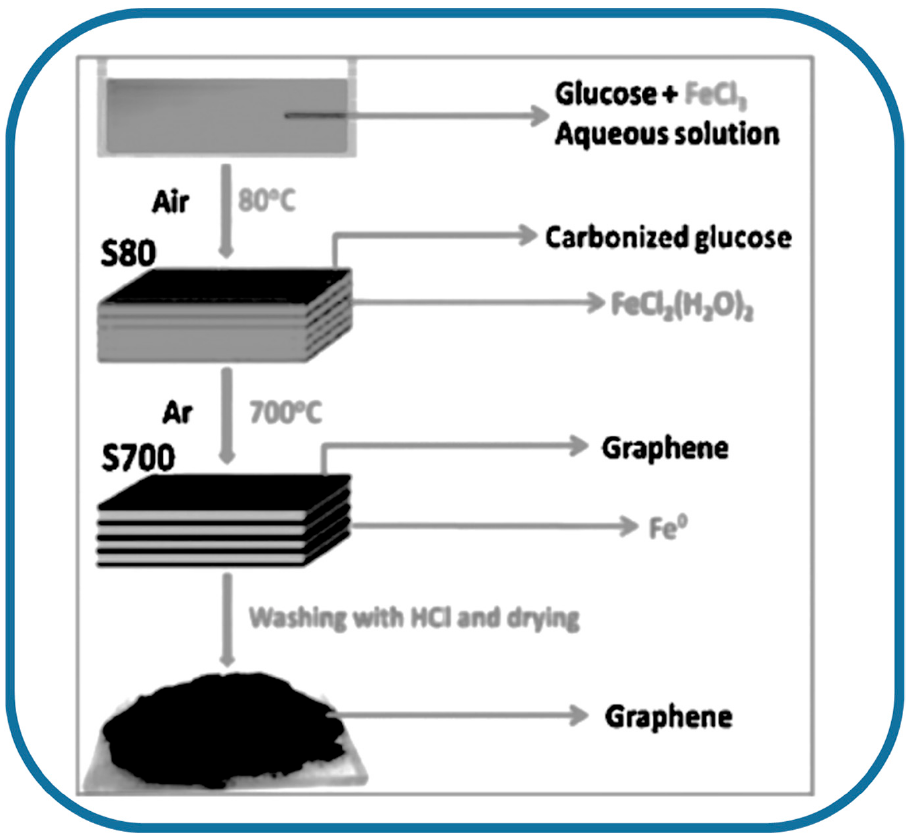
Figure 3. Preparation of graphene from glucose with the help of ferric chloride [37].